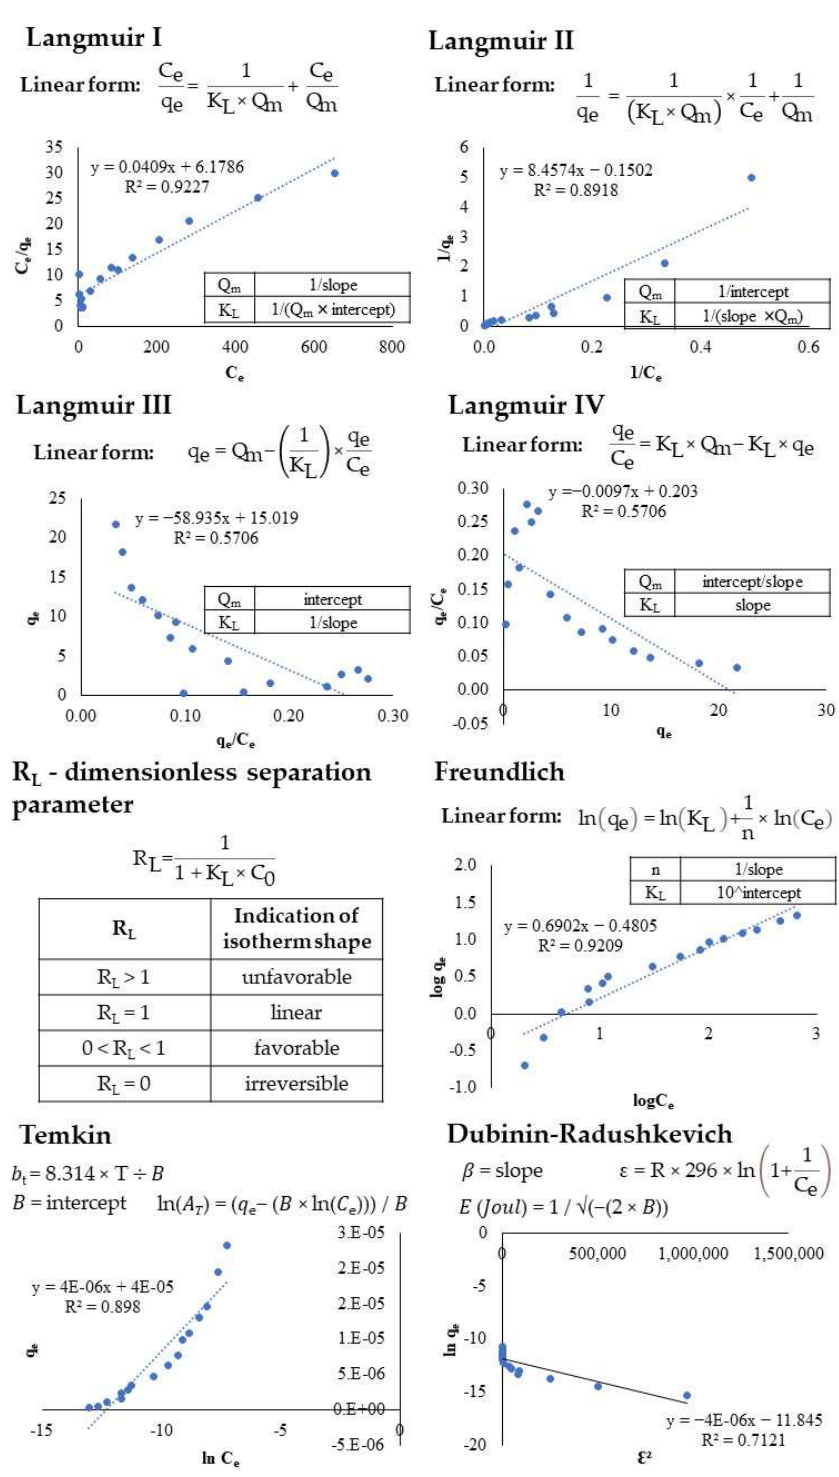
Figure 8. Representation of isotherm models in linear form .